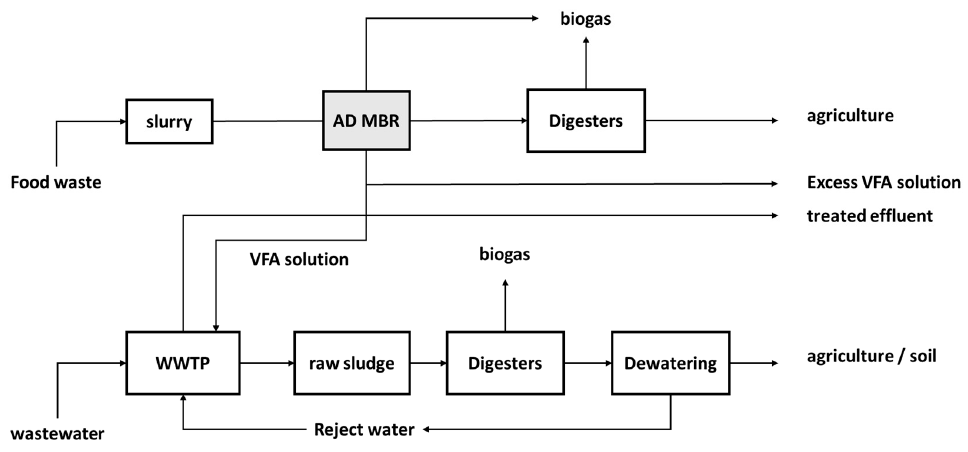
Figure 5. An overview of the proposed scenario one.